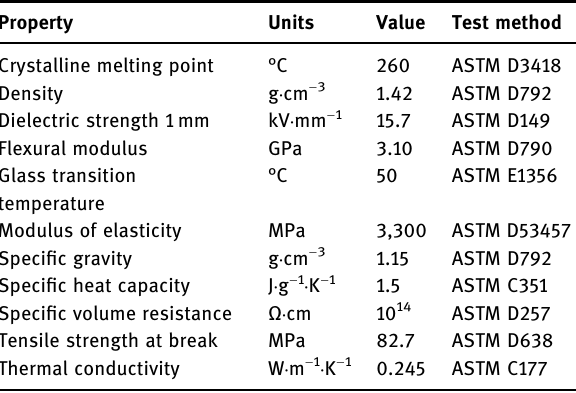
Table 1: Material properties of nylon 66 polymer ( 36 – 39 )